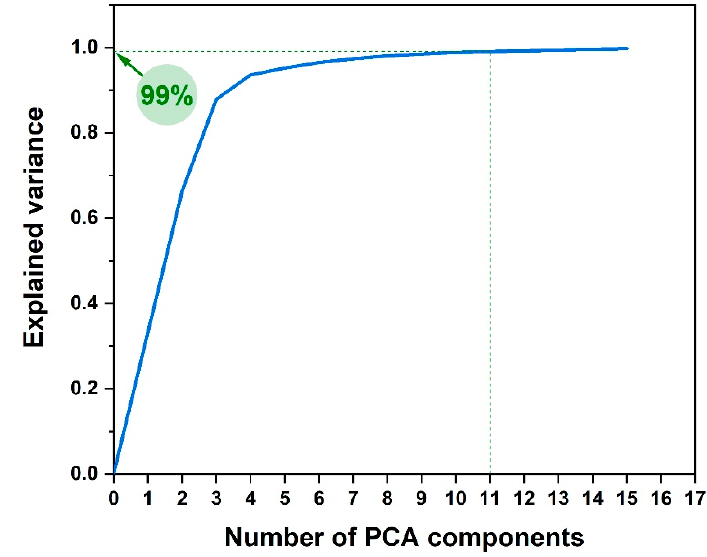
Figure 7. Explained variance as a function of Principal Component Analysis (PCA) components.